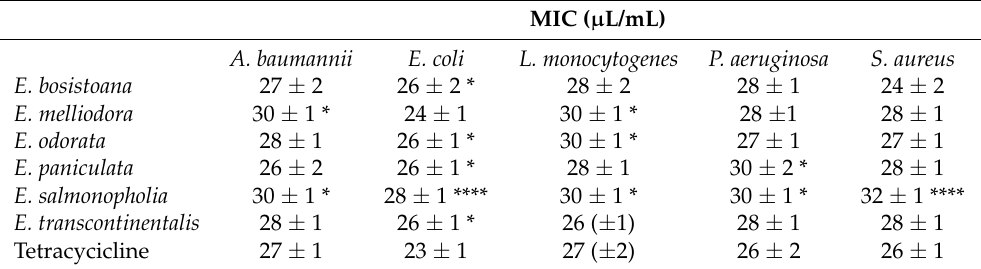
Table 3. MIC ( µ L/mL) of the Eucalyptus EOs required to inhibit the growth of A. baumannii , E. coli , L. monocytogenes, P. aeruginosa and S. aureus . Tetracycline was used as a positive control.